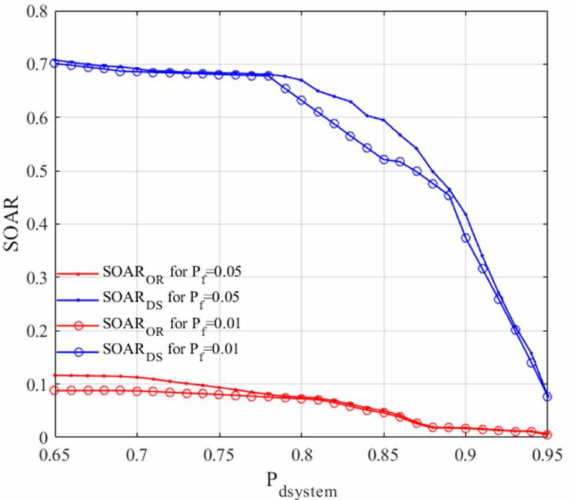
Figure 10. Spectrum Occupancy Awareness Ratio for different system probability thresholds and combination rules for scenario 1.